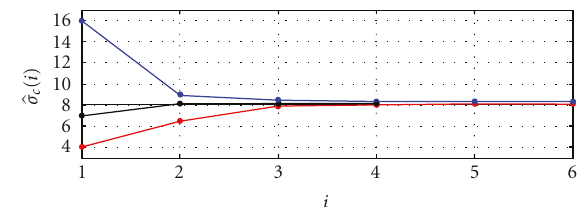
Figure 7: Noise STD estimation accuracy σ σ index k for the TID2008 database for noise variance σ 2 25 (blue curve), 65 (red curve), and 130 (black curve).